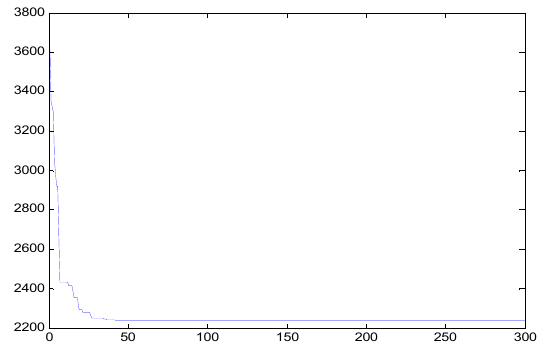
Figure 5. The plot for cost on distribution manufacturing system in MATLAB.